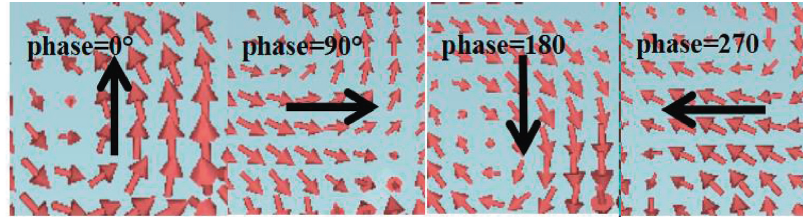
Figure 4: E-field around the aperture of one patch with 0 ° –270 ° feeding phases.